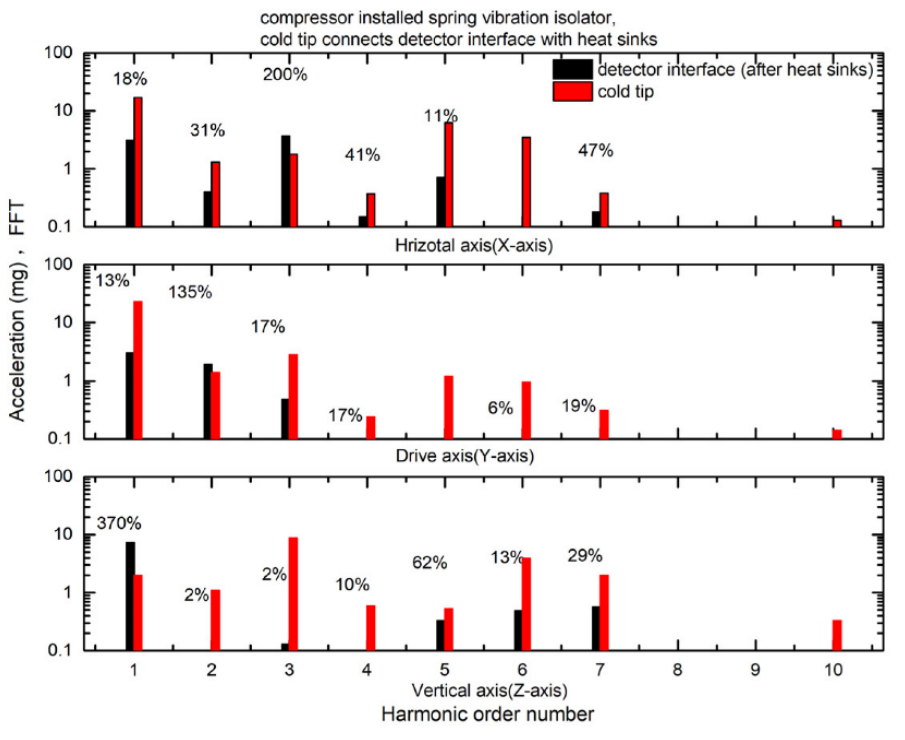
Figure 7. Test configuration for testing VR stage vibration isolation performance.